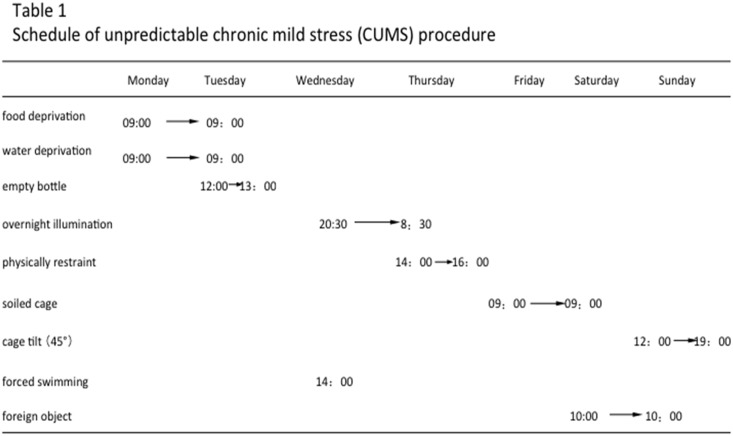
Schedule of unpredictable chronic mild stress (CUMS) procedure.The above stimulations were arranged for one random type of stimulation per day with no repeat of the same type of stimulation in continuous days, which would guarantee the animal will face unpredictable stimulation. The whole stimulation process lasted for 5 continuous weeks.